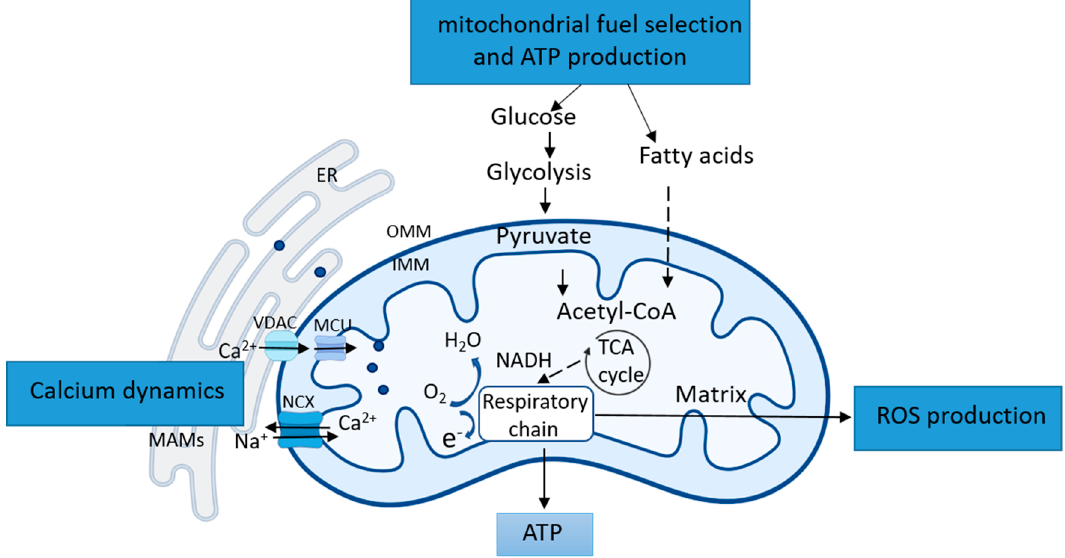
Figure 2. Overview of major mitochondrial functional remodeling. Mitochondria adapt to the cellular environment and stress to meet the energy demand under the various conditions through a serial of functional remodeling, such as the selection of fuel utilization and shift of metabolism, handling the dynamic calcium homeostasis and remaining the balance between reactive oxygen species (ROS) production and antioxidant defense. Multiple types of signaling are involved in these functional remodeling in mitochondria. TCA: tricarboxylic acid.OMM: outer mitochondrial membrane. IMM: inner